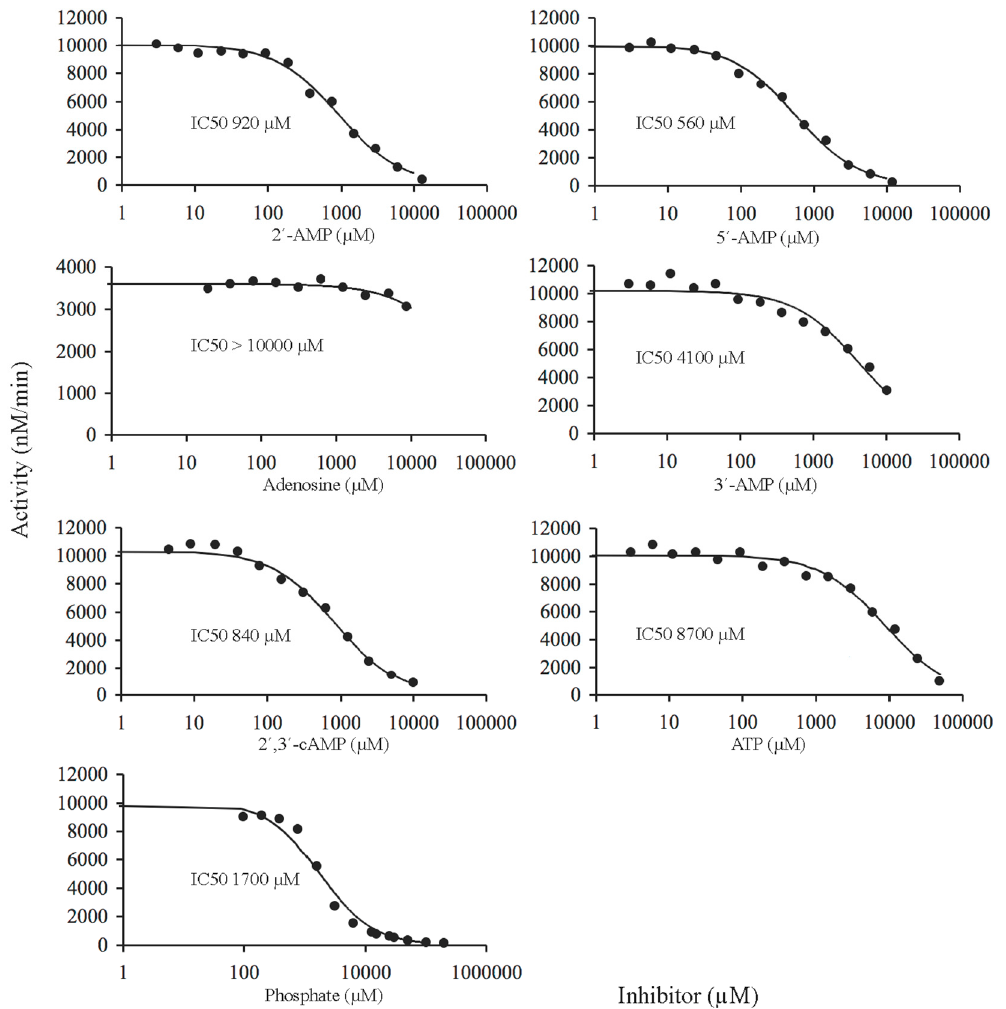
Figure 6. Inhibitor dose-response curves of CpdB_Ndom. IC50 is the inhibitor concentration causing 50% inhibition for each particular substrate-inhibitor combination. All the curves were recorded with 750 µM bis-4-NPP as the substrate. The panels are single illustrative experiments. The curves were obtained by fitting the equation for complete competitive inhibition to the experimental data as in Figure 7.